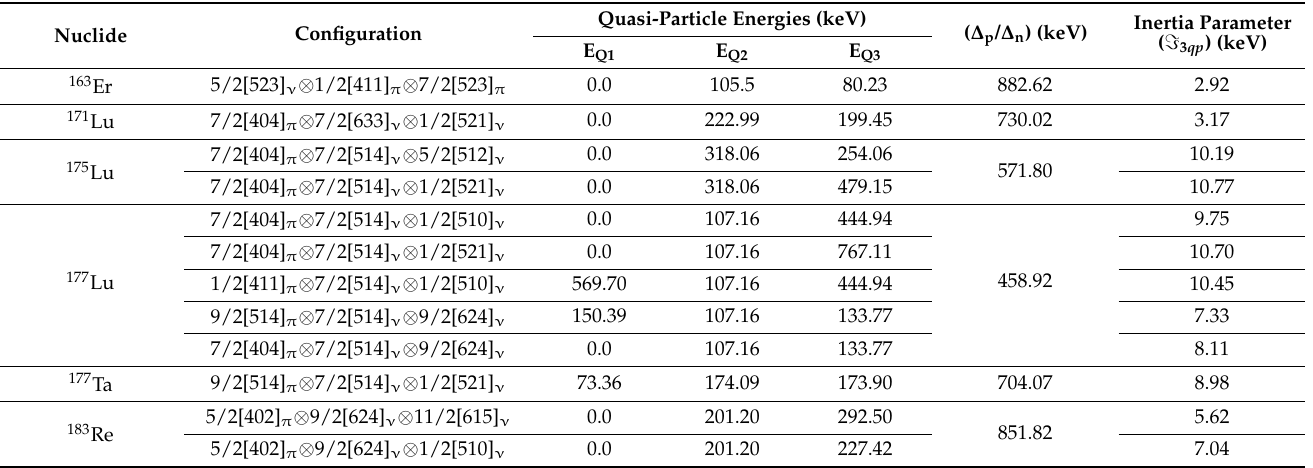
Table 1. Estimated values of quasi-particle energies, proton/neutron pairing energies and effective moments of inertia observed in 163 Er, 171,175,177 Lu, 177 Ta and 183 Re nuclides. Quasi-Particle Energies (keV) Nuclide Configuration